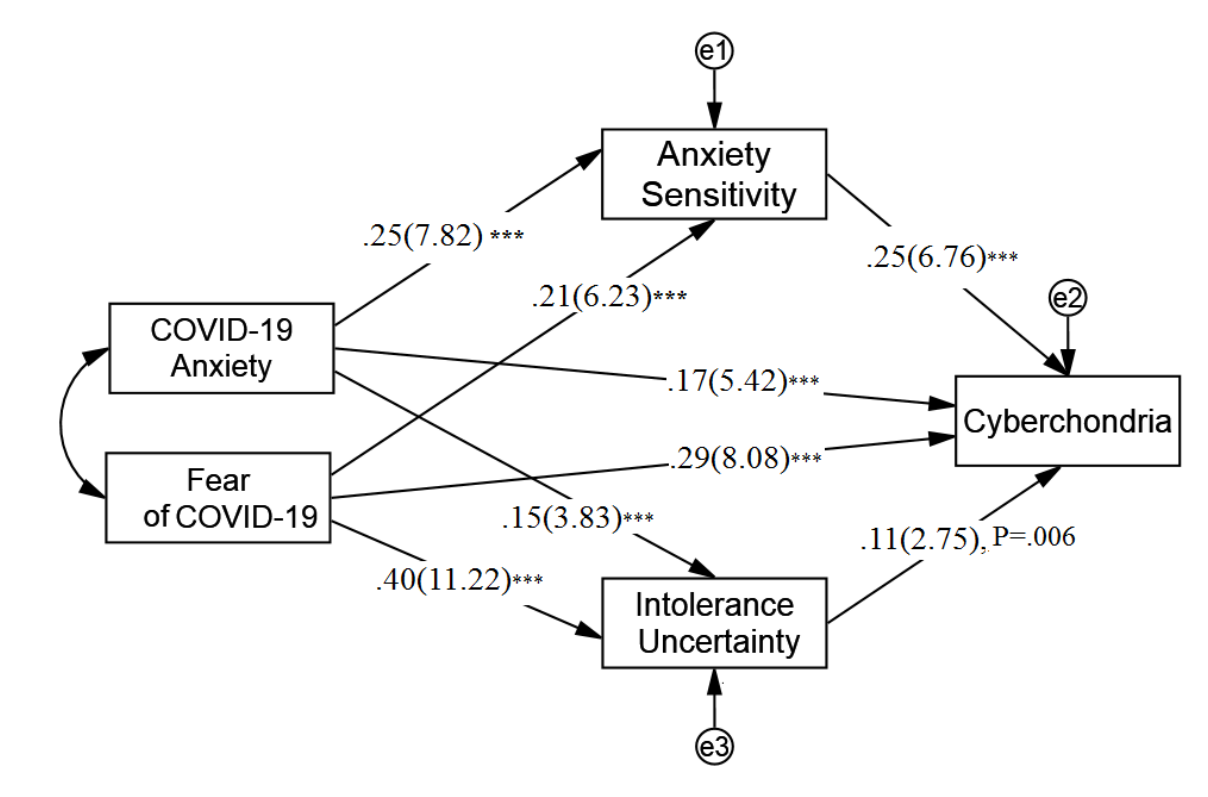
Figure 1. The multiple mediation model. Path coefficient: standardized coefficient ( t value). *** P <.001 level (two-tailed).